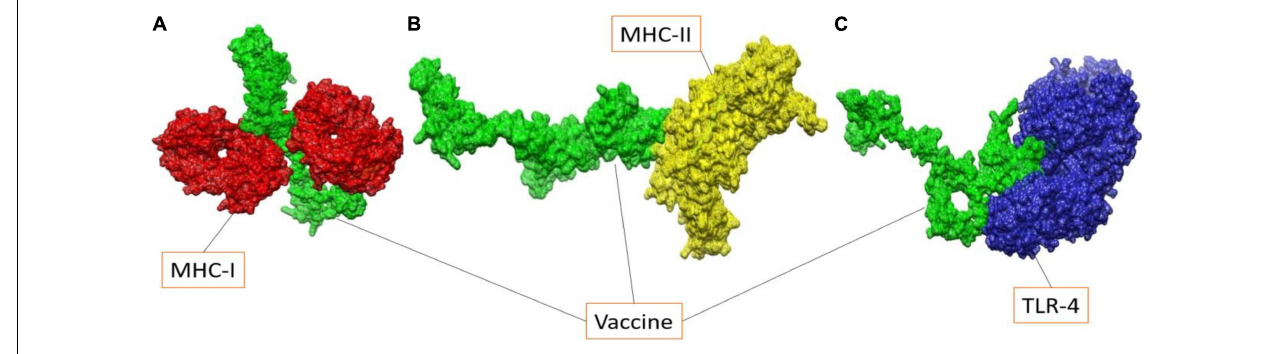
FIGURE 6 | Illustration of docked vaccine to MHC-I molecule (A) , MHC-II molecule (B) and TLR-4 molecule (C) .